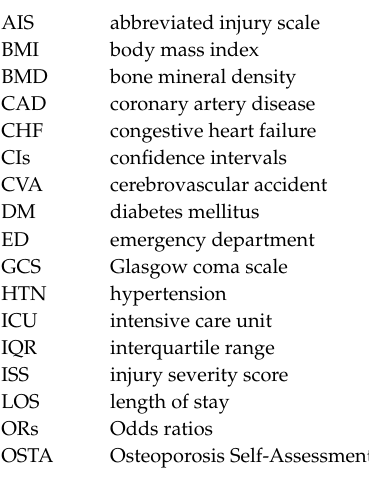
Table S1: Covariates of high-risk (OSTA < − 4) and low-risk (OSTA > − 1) patients before and after propensity score matching (1:1 matching via Greedy method), Table S2: Covariates of medium-risk ( − 1 ≥ OSTA ≥ − 4) and low-risk (OSTA > − 1) patients before and after propensity score matching (1:1 matching via Greedy